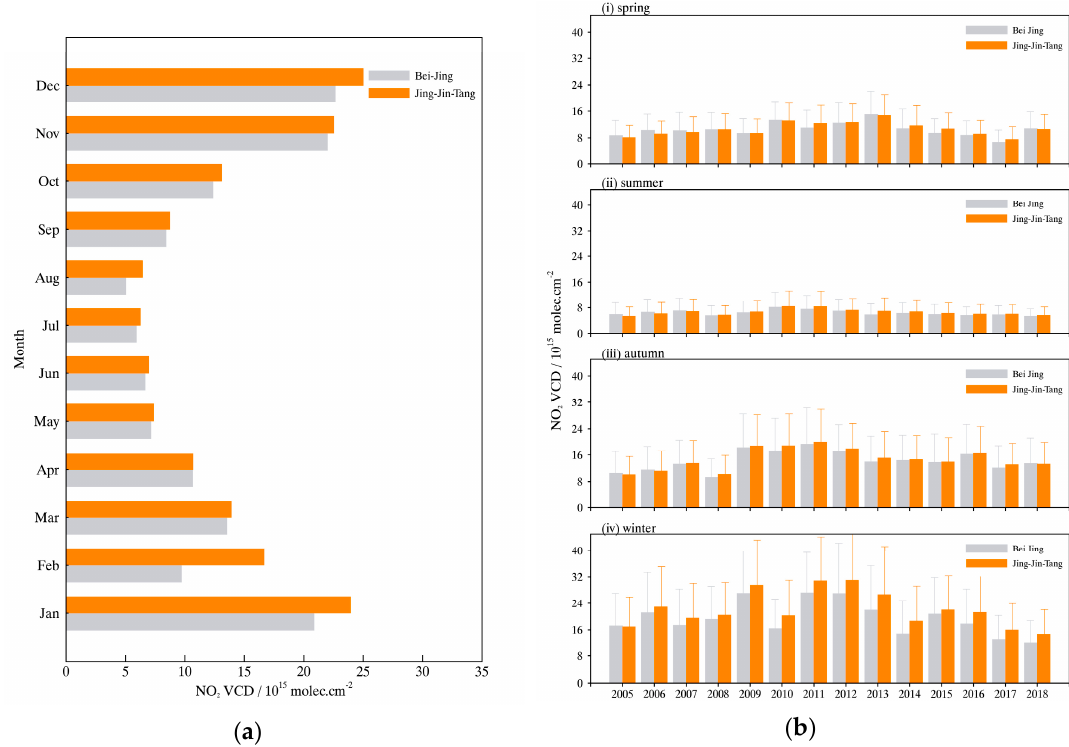
Figure 9. ( a ) Monthly averages in NO 2 columns in Beijing and Jing–Jin–Tang during 2005–2018 (unit: 10 15 molec cm − 2 ); and ( b ) seasonal variations in NO 2 columns in Beijing and Jing–Jin–Tang during 2005–2018 (unit: 10 15 molec cm − 2 ), with error bars representing the standard error.